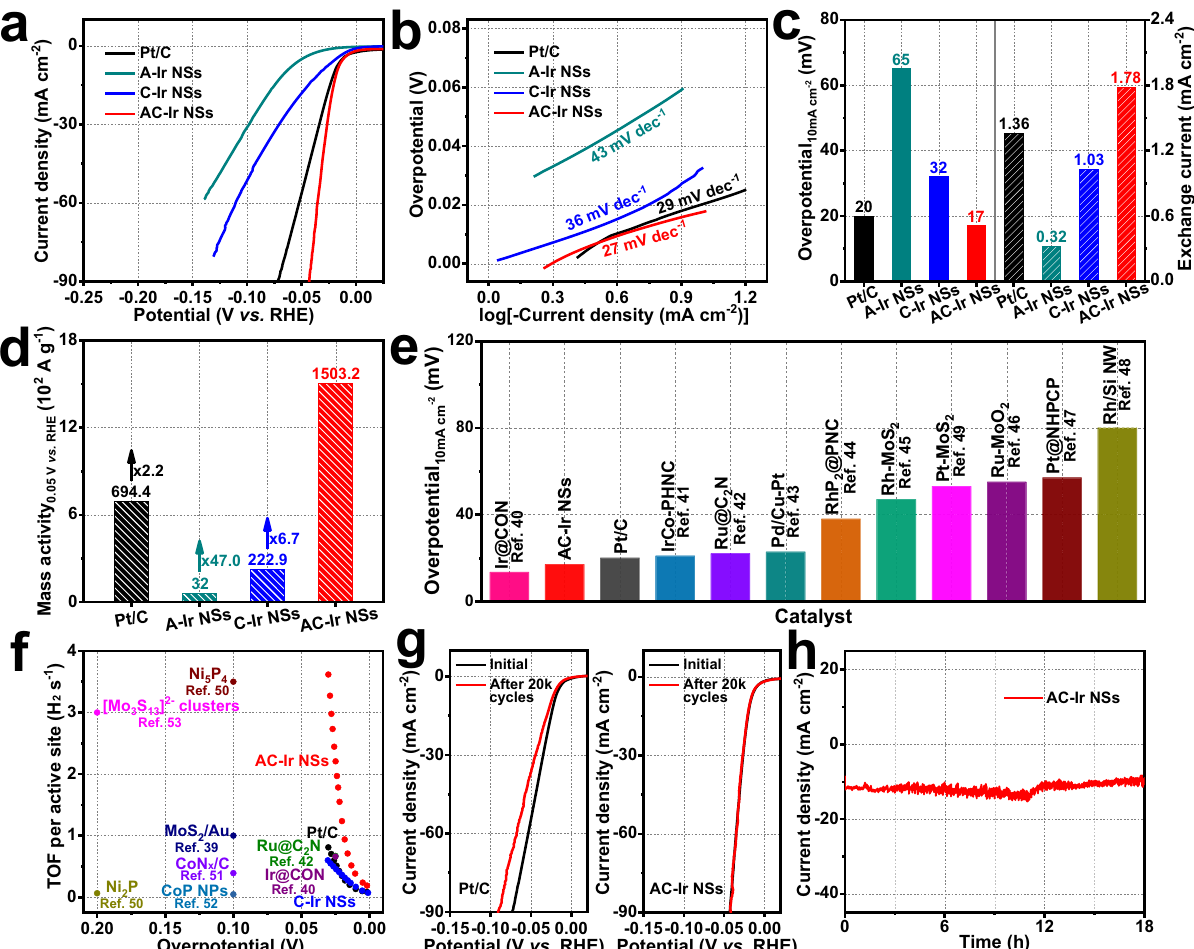
Fig. 6 Electrochemical HER performance of AC-Ir NSs. a Polarization curves, ( b ) The corresponding Tafel plots, ( c ) Comparison of the overpotential at 10 mA cm − 2 (left axis) and exchange current densities (right axis) and ( d ) Mass activity at an overpotential of 50 mV (vs. RHE) of AC-Ir NSs, C-Ir NSs, A-Ir NSs and Pt/C, respectively. e Comparison of the overpotential at 10 mA cm − 2 for AC-Ir NSs, Pt/C and recently reported HER catalysts 40 – 49 . f TOF values of AC-Ir NSs, C-Ir NSs, Pt/C and recently reported HER catalysts 39,40,42,50 – 53 . g Polarization curves of AC-Ir NSs before and after 20,000 cycles and ( h ) Chronoamperometry measurement at an overpotential of 17 mV (vs. RHE) of AC-Ir